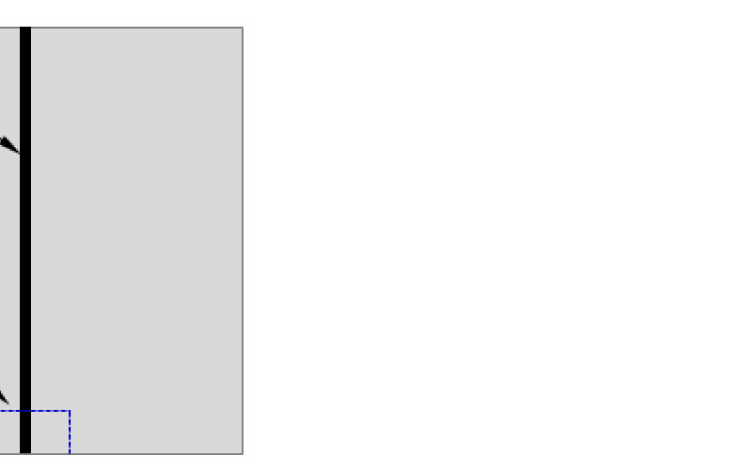
Figure 3. Schematic view of the specimen shape and cutting position for the microhardness and metallographic tests.